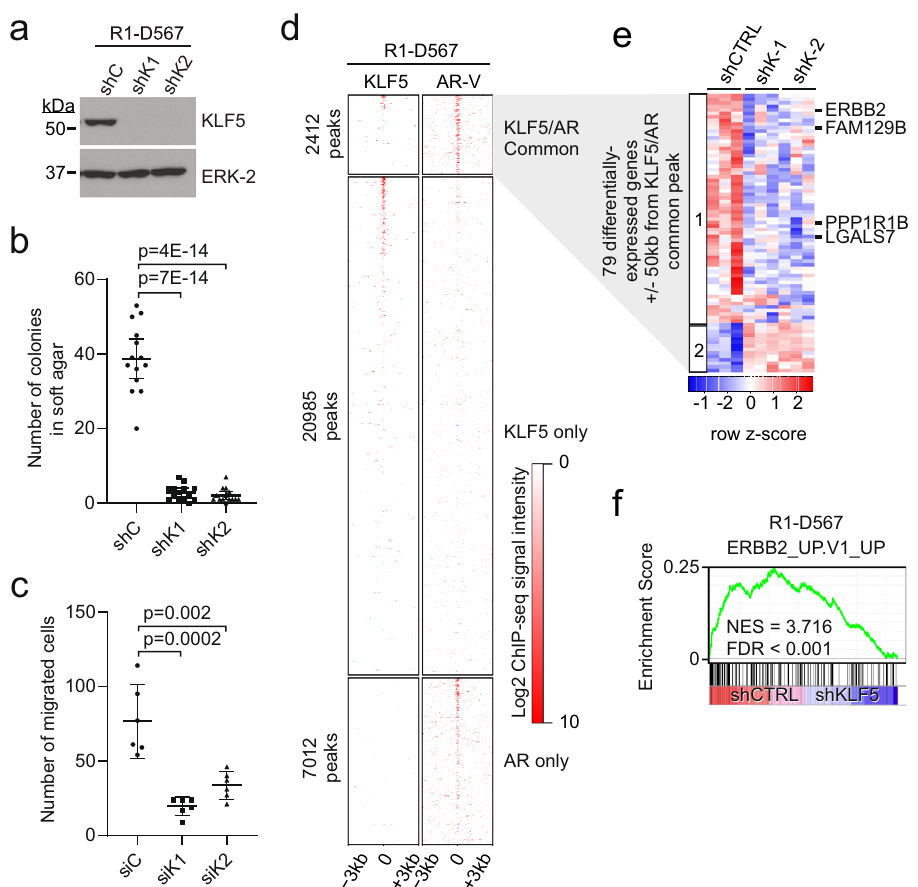
Fig. 7 KLF5 retains oncogenic function and activates ERBB2 in an enzalutamide-resistant CRPC cell line model of AR-V activity. a KLF5 protein measured by western blot using R1-D567 cells infected with control shRNA lentivirus (shC) or two independent KLF5-targeted shRNA lentiviruses (shK1 and shK2). ERK2 is a loading control. b R1-D567 cells as in a analyzed by 3D soft agar colony formation assays. n = 14, mean ± 95% CI from four independent experiments, two performed in biological triplicate and two performed in biological quadruplicate. P -values are unadjusted from 2-sided, 2-tailed t -tests. c R1-D567 cells transfected with KLF5-targeted siRNAs (siK1 and siK2) or control siRNA (siC) analyzed by chemotactic migration assays. n = 6, mean ±95% CI, two independent experiments in biological triplicate. P -values are unadjusted from 2-sided, 2-tailed t -tests. d Heatmaps of AR variant (AR-V) and KLF5 ChIP-seq signals ±3 kb around KLF5/AR common, KLF5 only, or AR only peaks in R1-D567 cells cultured in androgen-deplete medium. e Heatmap of RNA-seq gene expression data for a set of 79 genes located ±50kb from a KLF5/AR common peak and differentially expressed in R1-D567 cells based on comparisons between shRNA control (shCTRL) vs. shKLF5 conditions and/or DHT vs. vehicle conditions. The heatmap was generated by unsupervised clustering, revealing two main clusters. f GSEA testing enrichment of the signature ERBB2_UP.V1_UP in R1-D567 gene expression data re fl ecting active KLF5 (differential expression in shCTRL vs.